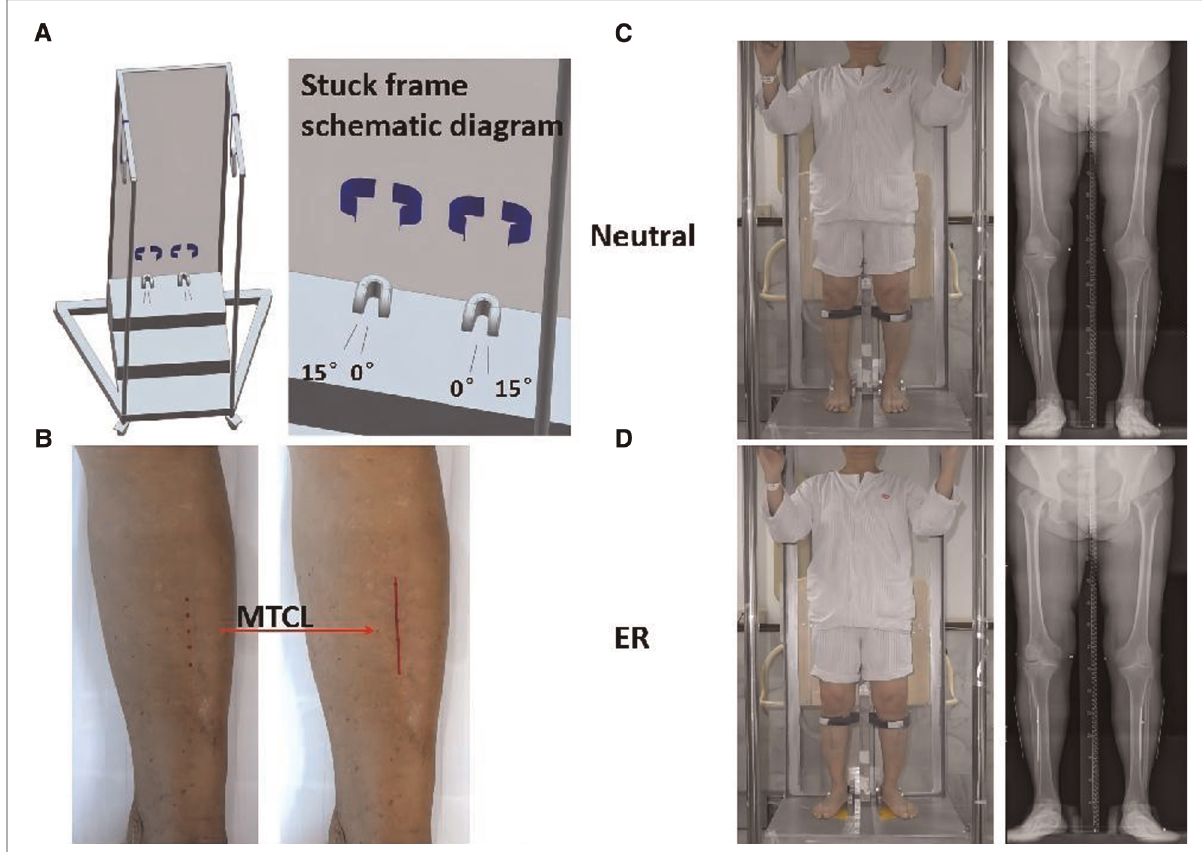
FIGURE 1 Participants underwent anteroposterior (AP) standing radiographs of the lowerextremities. ( A ) Secure frameschematic diagram. The feet are aligned on the platform with the center between the toes and heels of feet I and II, and the superior tibial crest is secured. ( B ) The middle tibial crest line (MTCL) is marked on the skin (red line). ( C,D ) A secure frame is used to perform radiographs: feet positioned straight ahead (neutral) and at 15° of external rotation